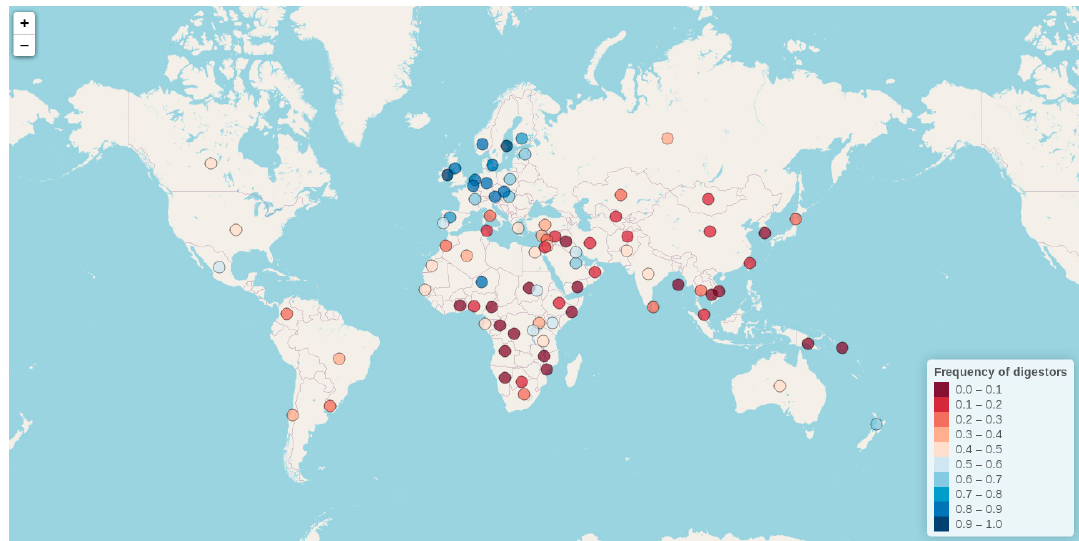
Figure 3. Interactive map exploring the lactase persistence (LP) frequencies worldwide (http://bionit.ugr.es/pages/investigacion/software/bioinformatics-methods-software). It includes all available literature reports on LP frequencies till 20 July 2020. It also offers a detailed description for each included study (incorporating information related to geographical location, ethnicity, number of individuals analyzed, reported frequency, and literature references). The figure presented here represents a static capture of the map (showing mean LP frequencies per country).